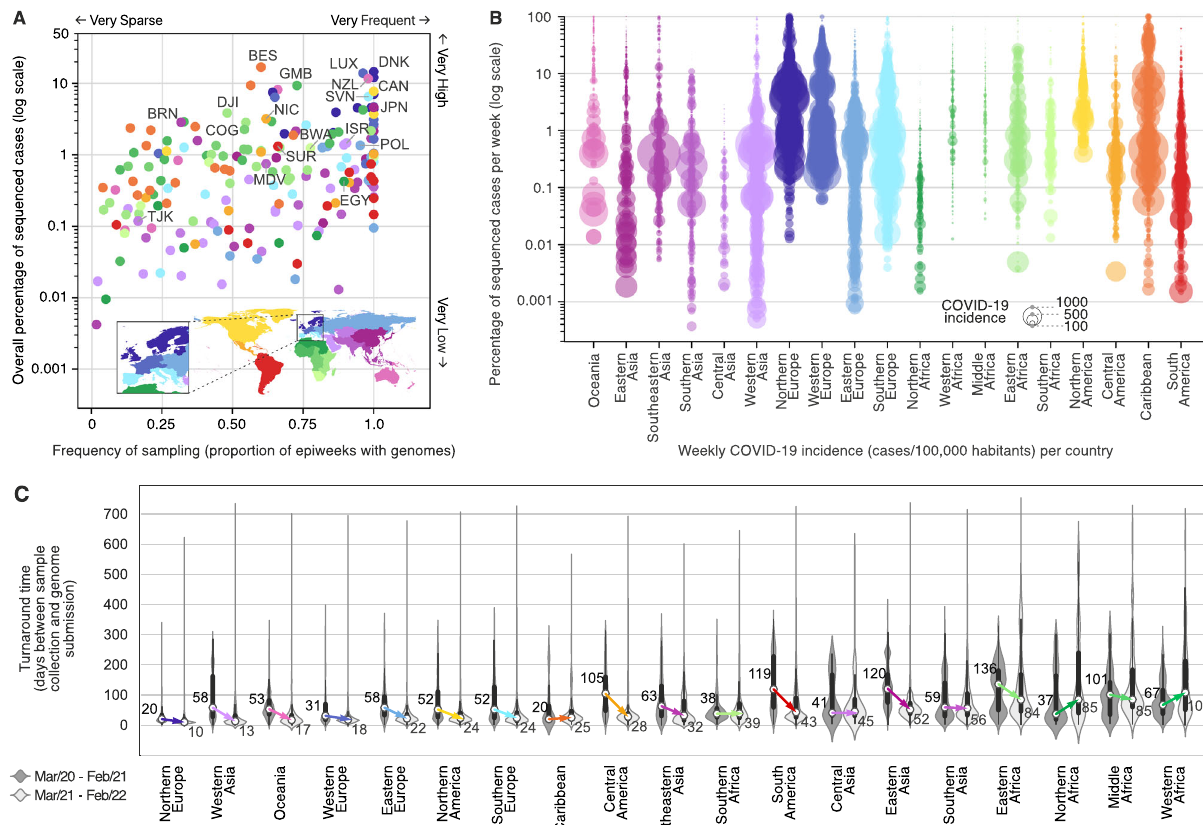
per EW per country, per geographic region. Each circle represents an EW with at least one sequenced case; circle diameters represent incidence, de fi ned here as number of reported cases per 100,000 people per EW per country. C Distribution of turnaround times of genomes collected in different geographic regions during the fi rst year (from March 2020 to February 2021) and second year (from March 2021 to February 2022) of COVID-19 pandemic, grouped by year of submission ( n =8,947,455 genomes). The elements in the violin plots represent the median TATs (white circles), the interquartile range (black rectangles) and the minimum andmaximumdatapointsinthedatasets(blackverticallines).Thearrowshighlight the changes in the median TATs between the fi rst and second year of